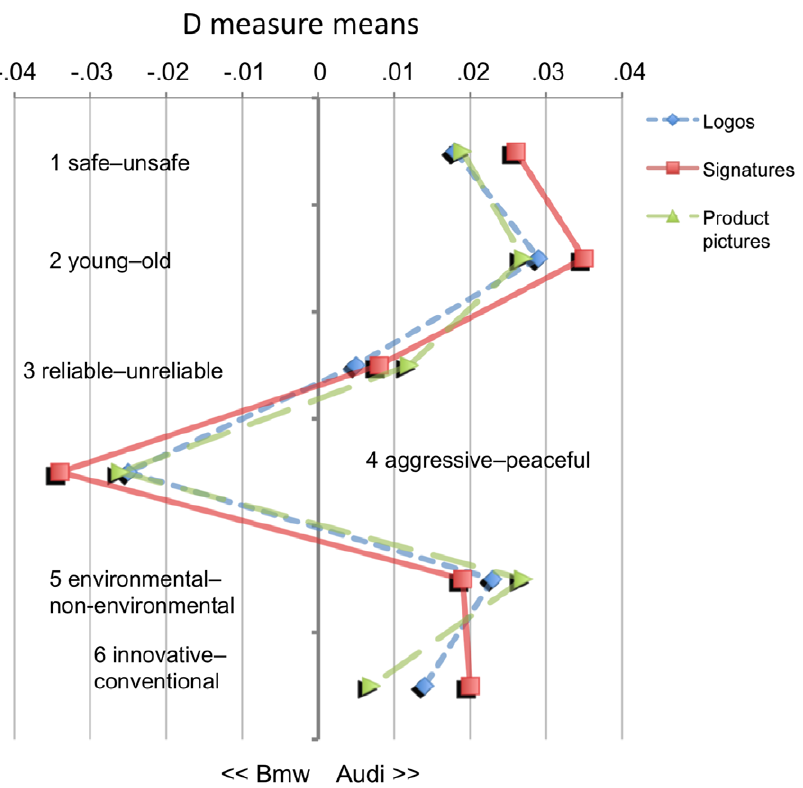
Figure 3. Study 2 (‘‘AUDI vs. BMW’’): D measure means for every single IAT ( N =26) resulting from combinations of the two factors ATTRIBUTE DIMENSION and BRAND